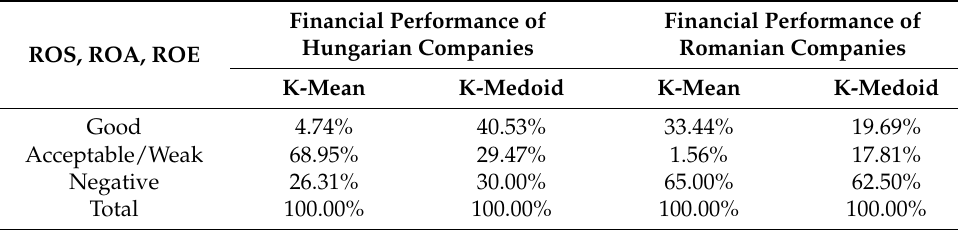
Table 8. Financial performance of Hungarian and Romanian food retail companies. Financial Performance ROS, ROA, ROE